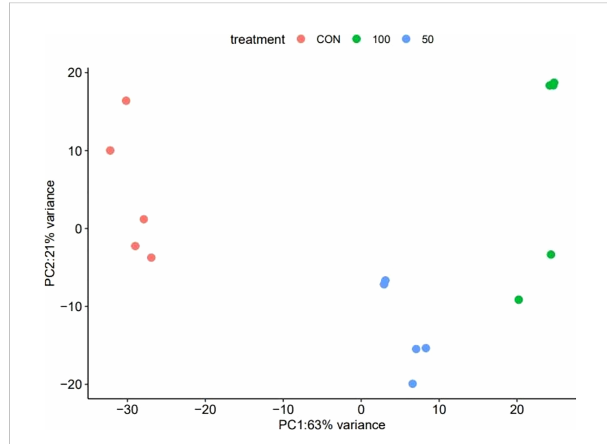
FIGURE 5 The principal component analysis of Limonium tetragonum under different NaCl concentrations ( n = 5).